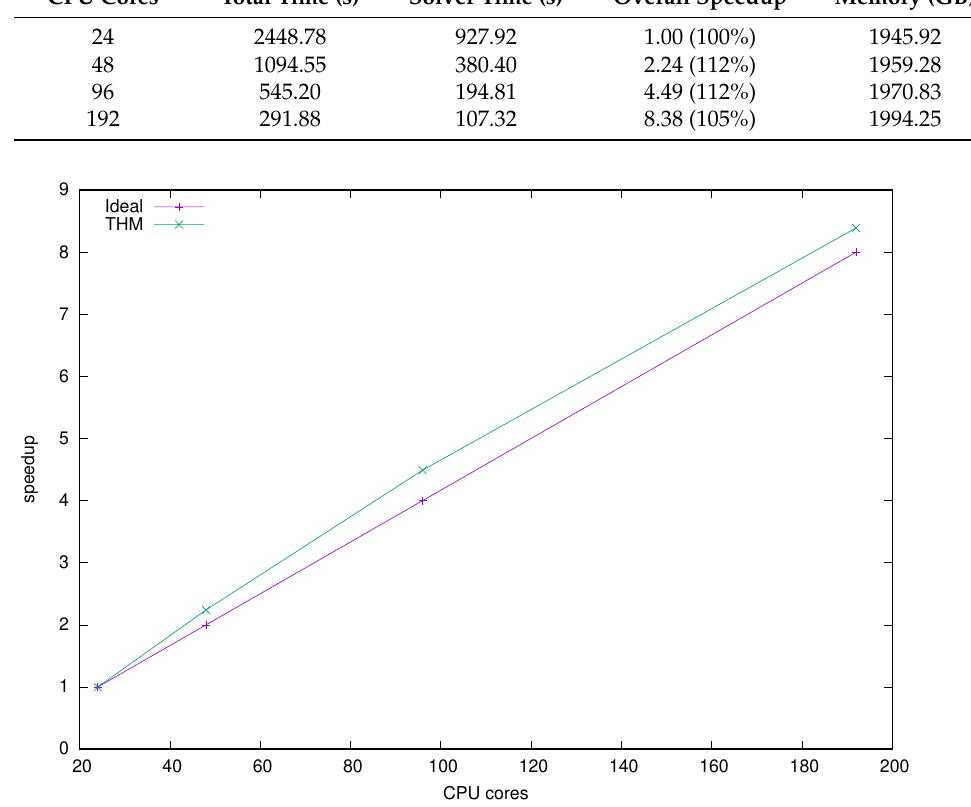
Figure 16. Example 6: scalability